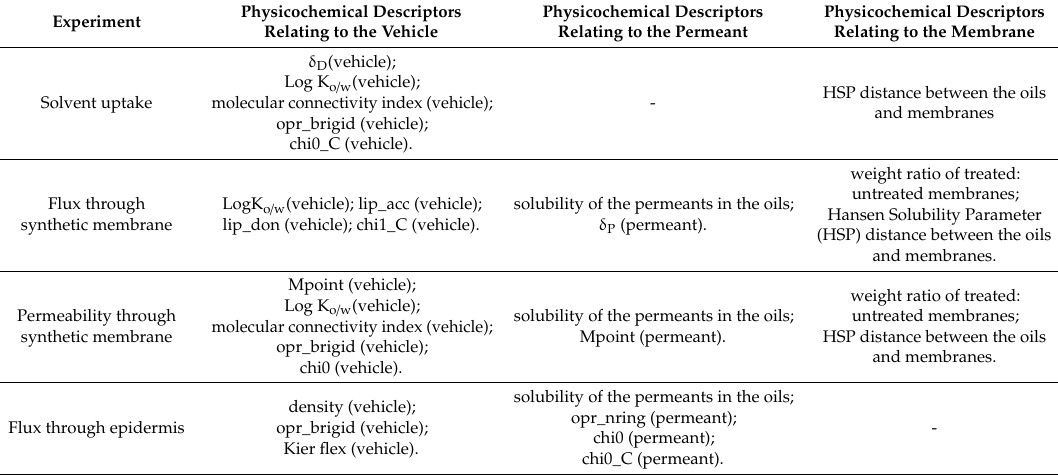
Table 2. Physicochemical descriptors, categorized according to whether they are related to the vehicle, permeant or membrane, that were identified by Principal Components Analysis (PCA) as important for explaining the variation in experimental observation for the solvent uptake, flux through membranes, and permeability coe ffi cient through synthetic membranes and flux through